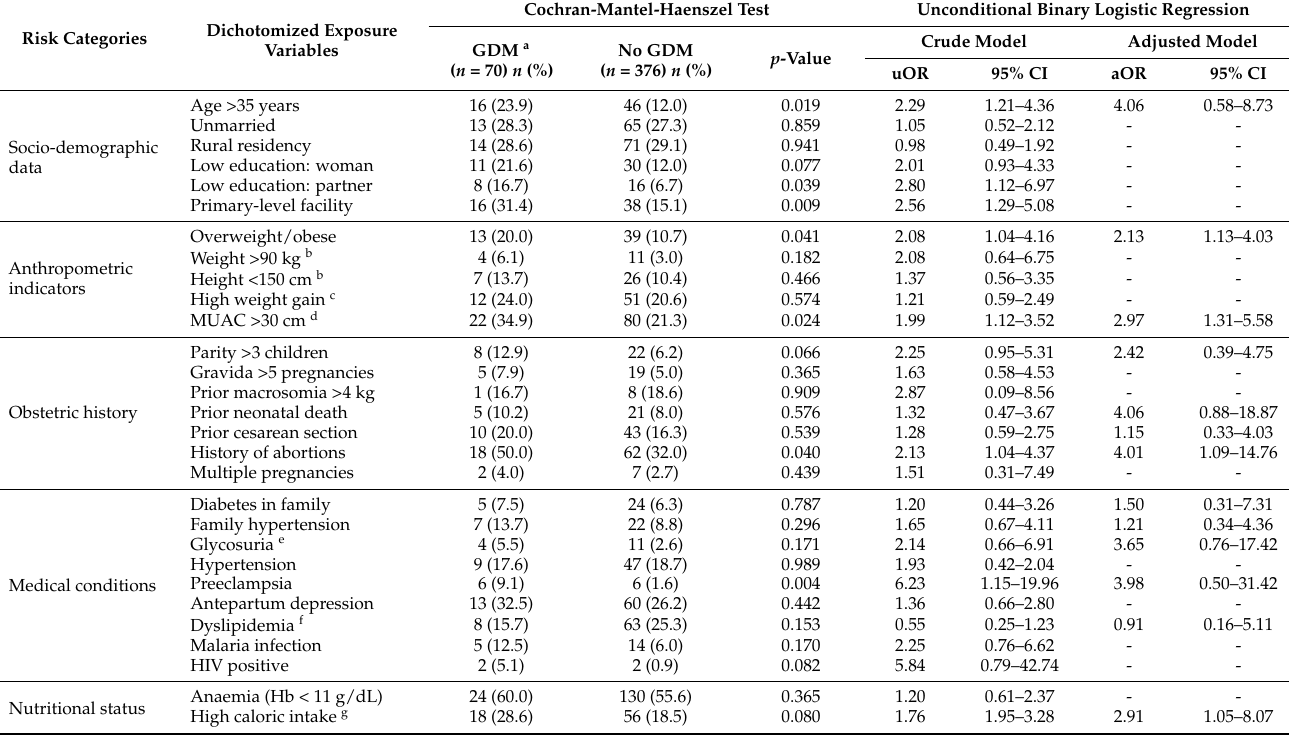
Table 3. Socio-demographic, health and nutritional status indicators and the risk factors for gestational diabetes mellitus.